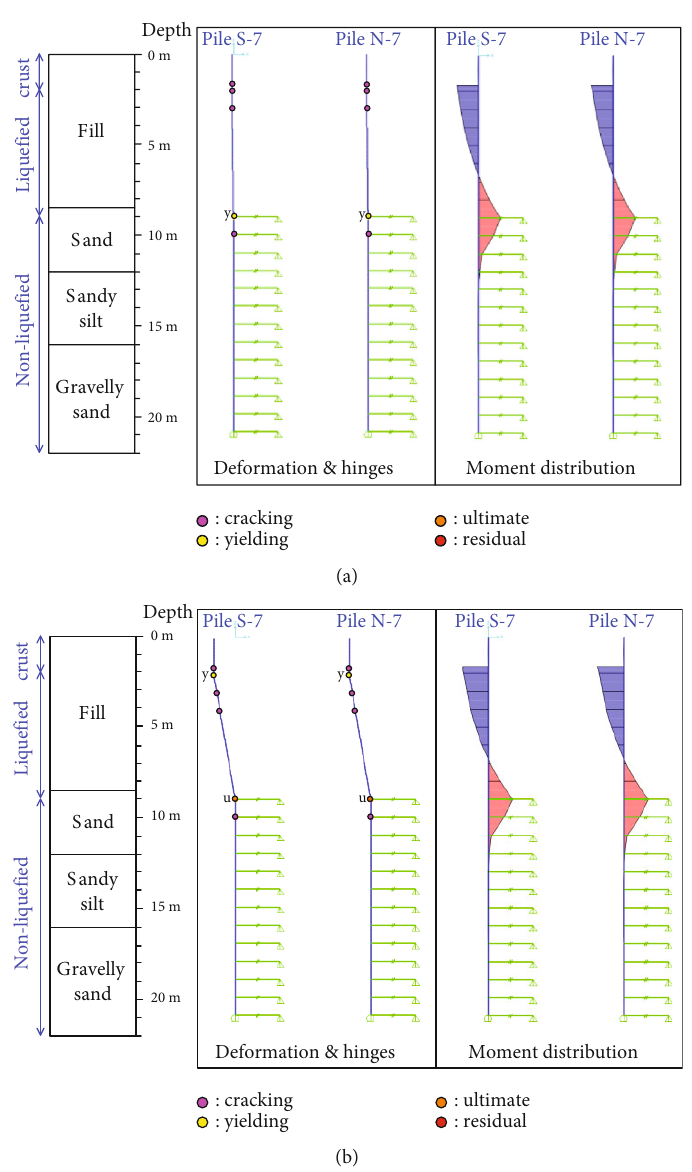
Figure 9: Deformation, plastic hinges, and moment distribution along the piles (lateral spreading as fl ow pressure, no axial load). (a) Yielding state. (b) Ultimate state. (Final state not